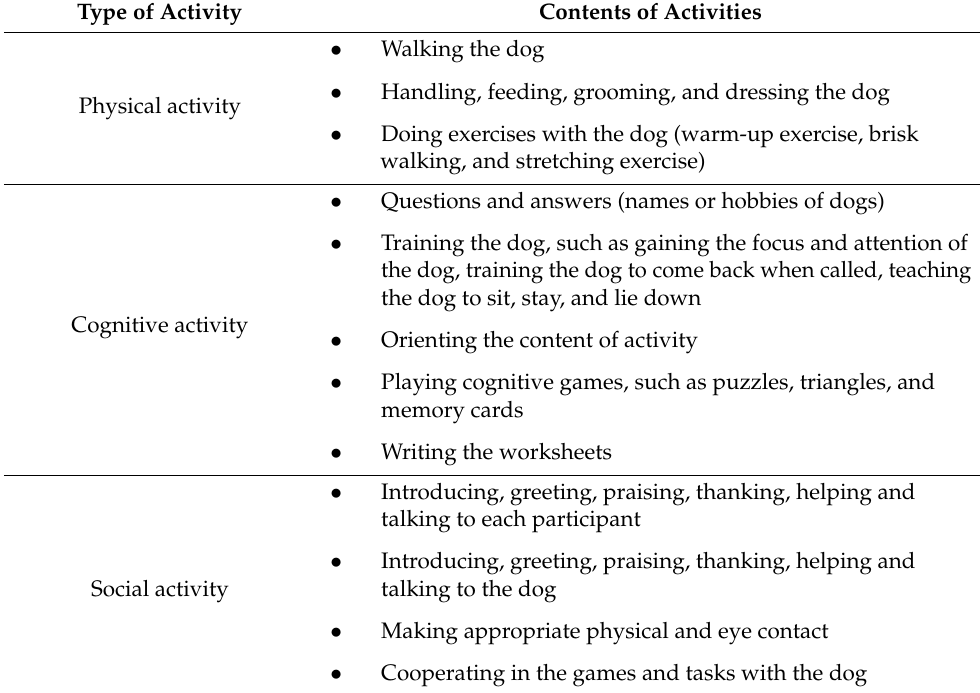
Table 1. Contents of animal-assisted